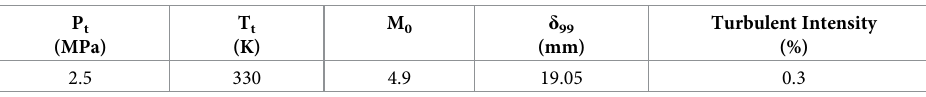
Table 1. Inlet conditions of the scramjet inlet isolator